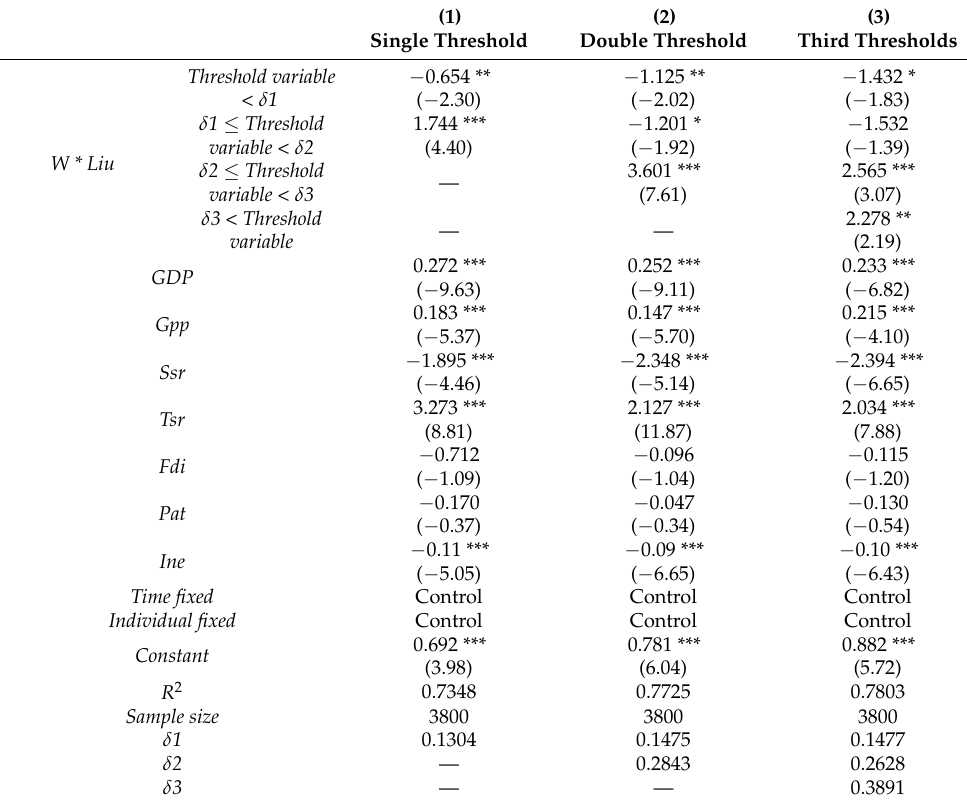
Table 6. Spatial threshold effect